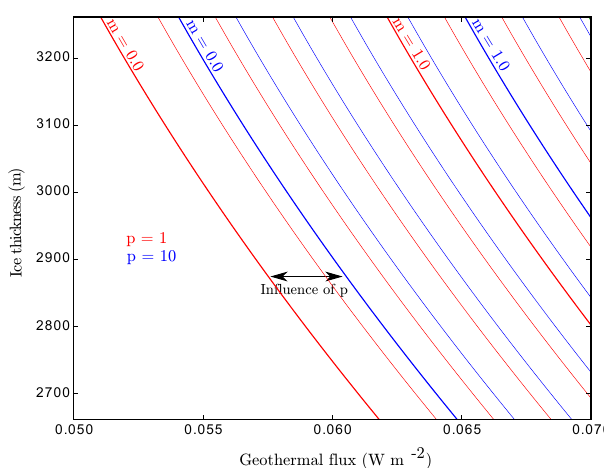
Figure 6. Basal melt rate m in mma − 1 , depending on the ice thick- ness, GF and shape parameter p